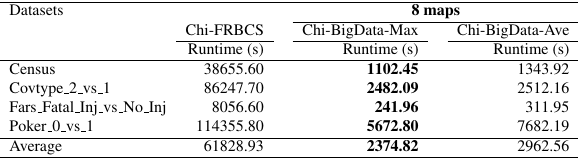
Table 4. Average runtime elapsed in seconds for the Chi- FRBCS versions